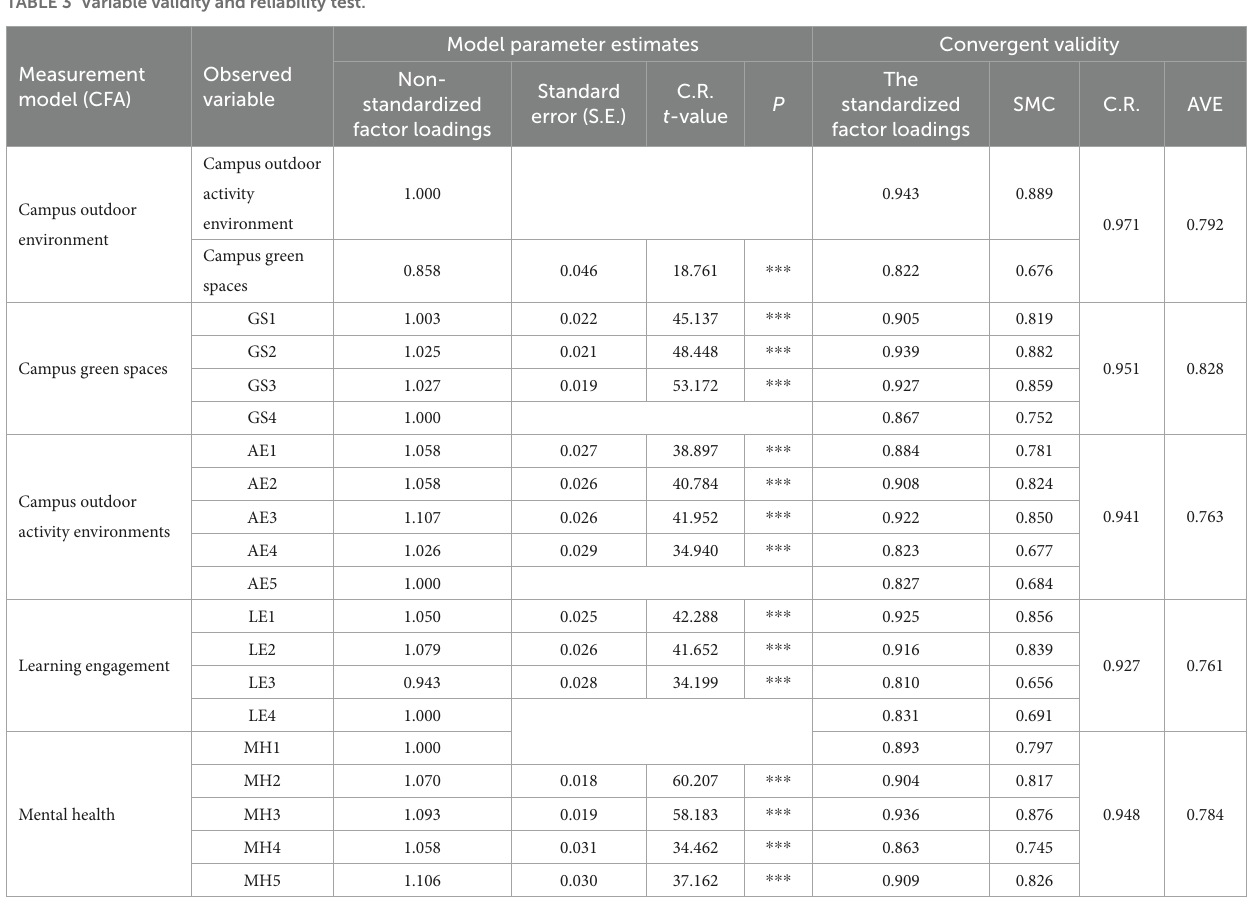
TABLE 3 Variable validity and reliability